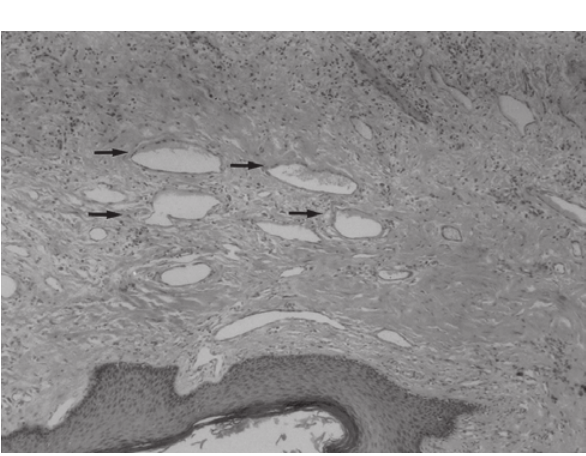
Figure 1 – Microscopic examination of scrotal lesion (1400X magnification). Arrows indicate lymphatic ducts with ectasia and interstitial edema with chronic inflammatory